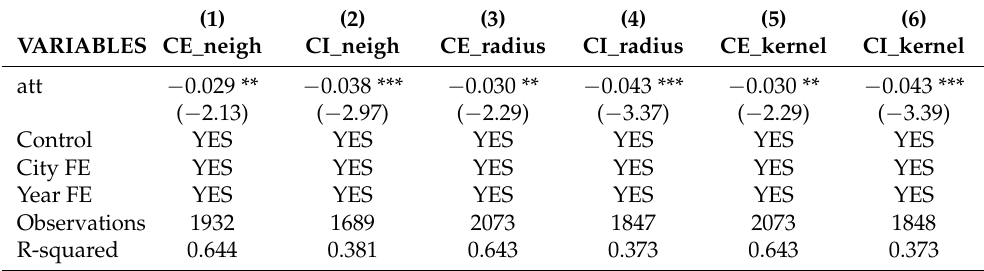
Table 10. Estimation results of propensity score